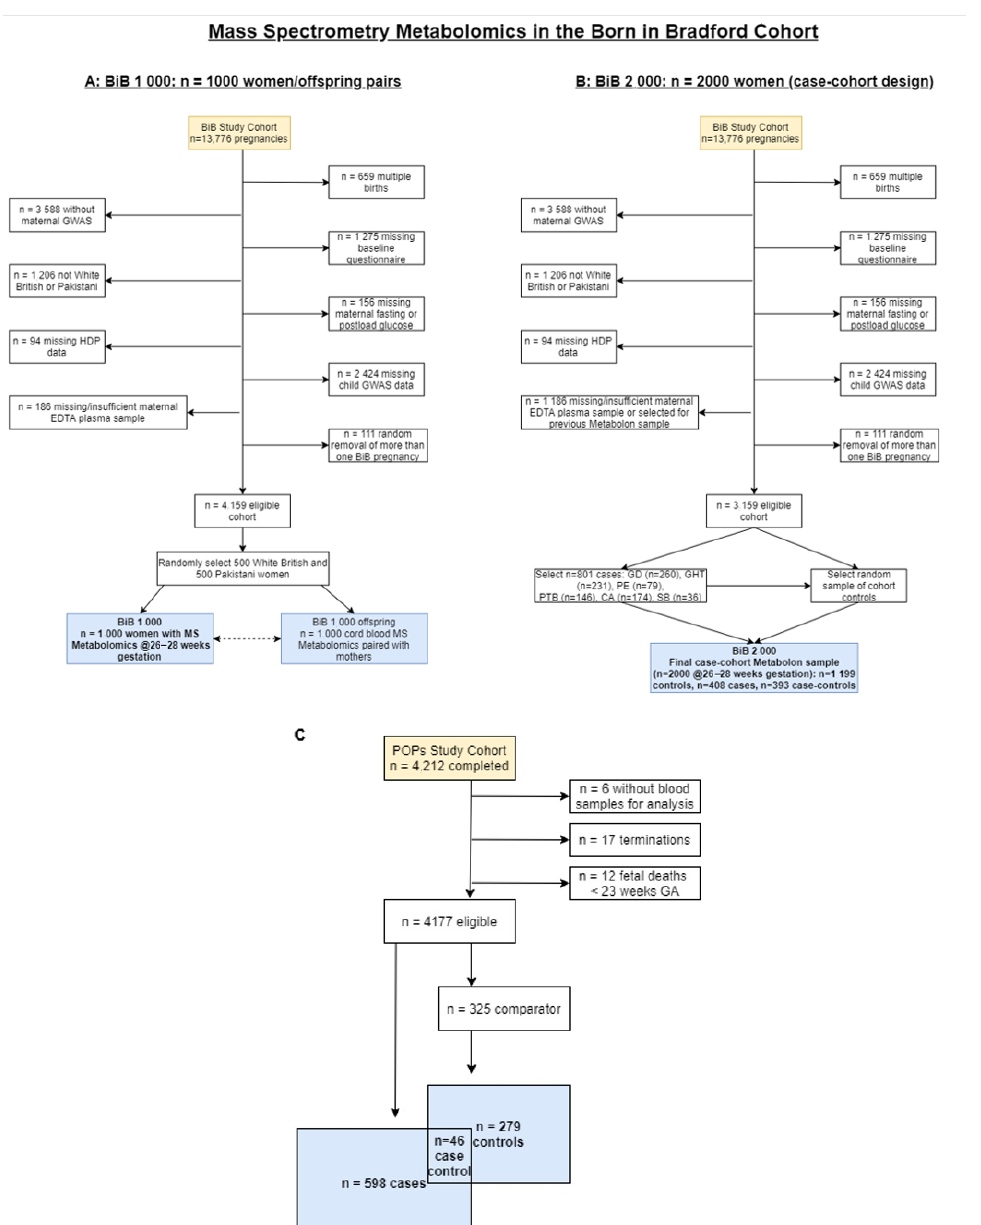
Figure 5. Born in Bradford flowchart: the selection of participants for mass spectrometry metabolomic profiling in the Born in Bradford 1000 ( A ) and 2000 ( B ). Abbreviations: MS, mass spectrometry; BiB, Born in Bradford; GWAS, genome-wide association study; EDTA, ethylenediaminetetraacetic acid; HDP, hypertensive disorders of pregnancy; GD, gestational diabetes; GHT, gestational hypertension; PE, pre-eclampsia, PTB, preterm birth; CA, congenital anomaly; SB, still birth. ( C ) Illustrating the flow of participants into the Metabolon datasets (( A ) BiB 1000, ( B ) BiB 2000 and ( C ) POPs ( n = 923) cohorts). Abbreviations: MS, mass spectrometry; BiB, Born in Bradford; GWAS, genome-wide association study; EDTA, ethylenediaminetetraacetic acid; HDP, hypertensive disorders of pregnancy;